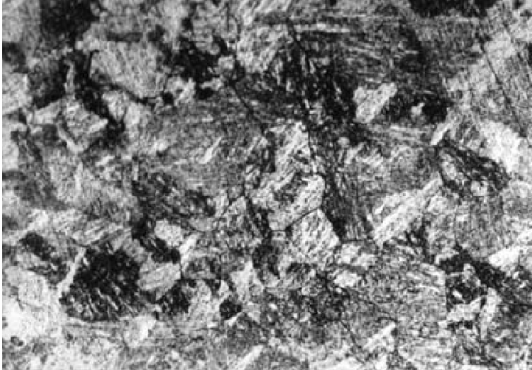
Fig. 9. Microstructure of aging samples at 650 o C for 5 hours (200X).